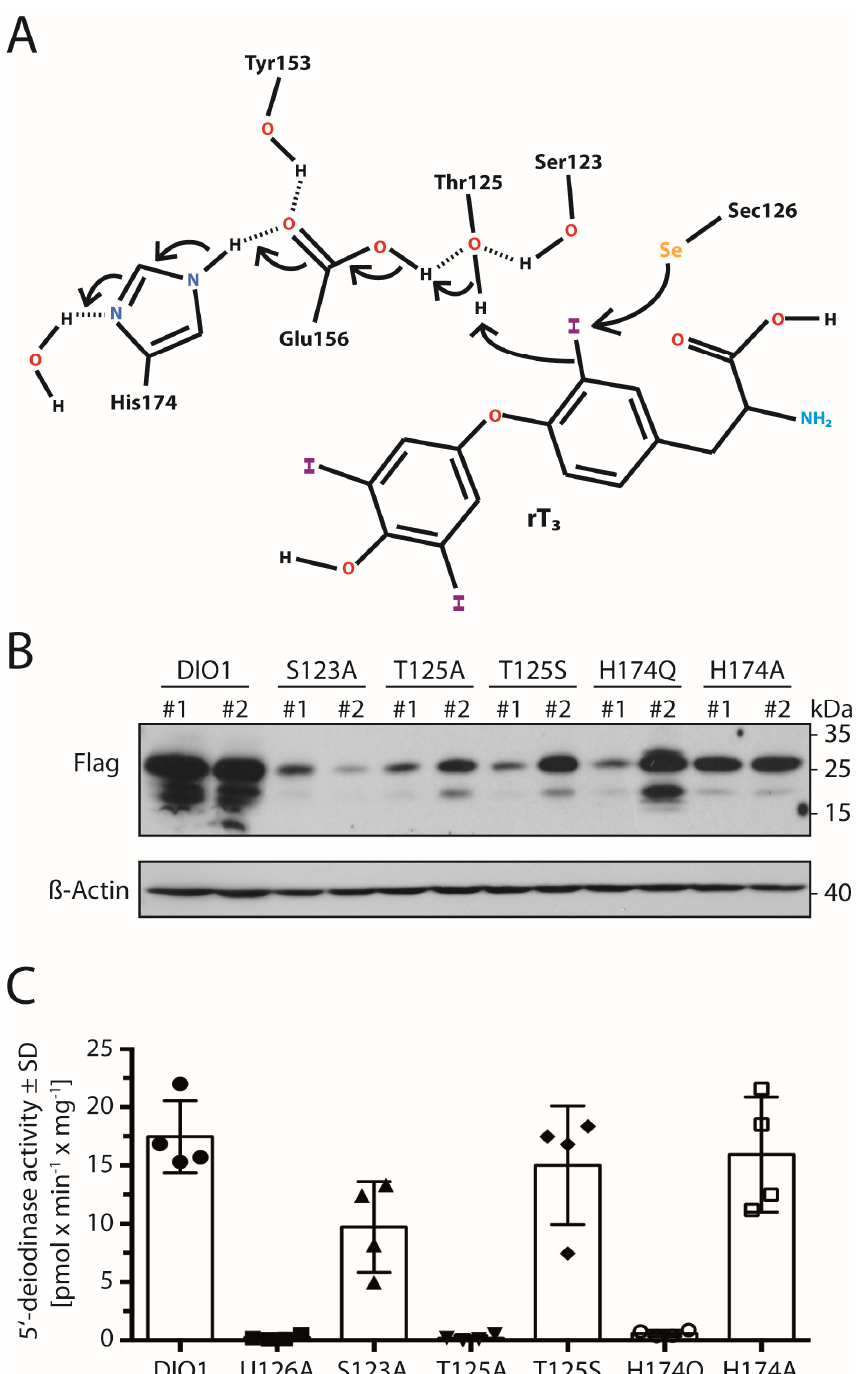
Figure 7. Amino acid residues in DIO1 possibly involved in a proton relay pathway. ( A ). Schematic representation of the conserved hydrogen-bond network. Arrows indicate electron shifts for a potential proton relay. ( B ). Western blot analysis of DIO1 in stable COS7 clones directed against the Flag-tag. ( C ). 5 ′ -deiodinase activities of DIO1 variants expressed in COS7 cells. 20 mM DTT served as reducing co-factor. SD: standard deviation.